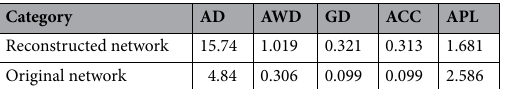
Table 1. Network topology characteristics before and after network